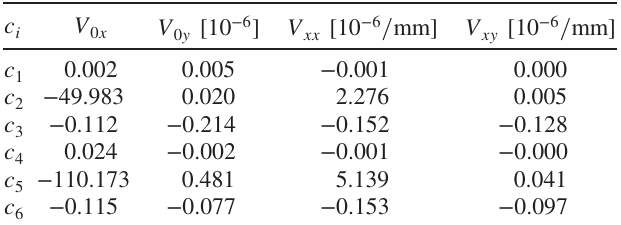
TABLE V. Fit parameters from Eq. (18) for downstream coupler kick coefficients for the reflection dependent part, V Γ d